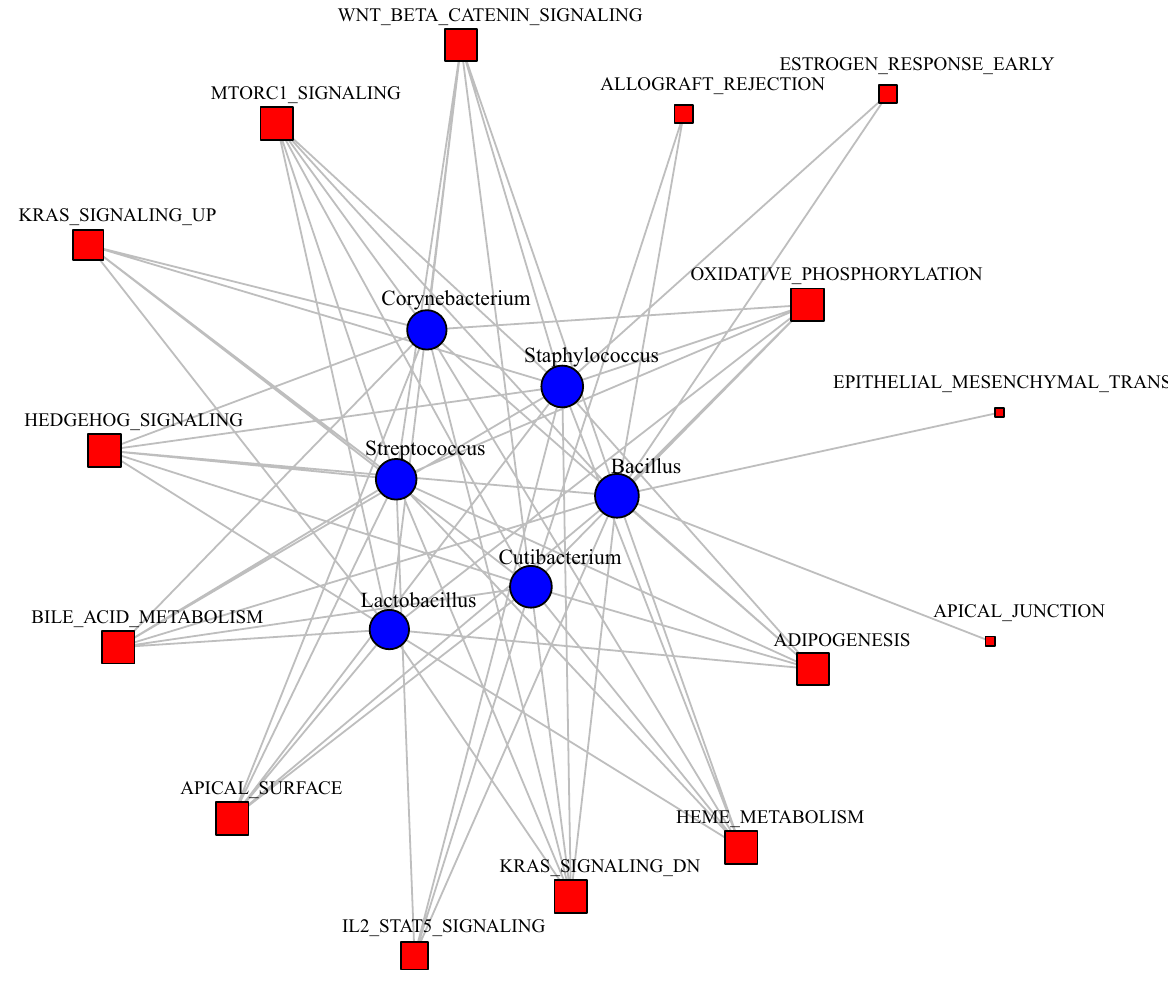
Figure 3. Community from the bipartite network from the host-microbiome interaction analysis with relevance to COPD, dyspnea and smoking associations. Edges represent a significant (FDR < 5%) association between genus abundance (blue circles) and the expression of the human Hallmark pathway (red squares) in the meta-analysis (figure produced using the R package igraph 52